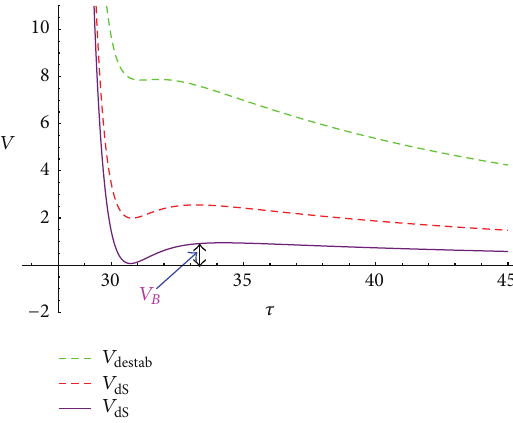
Figure 7: The purple curve shows the dS vacuum, while the green one displays the destabilization of the modulus due to large contribution of vacuum energy